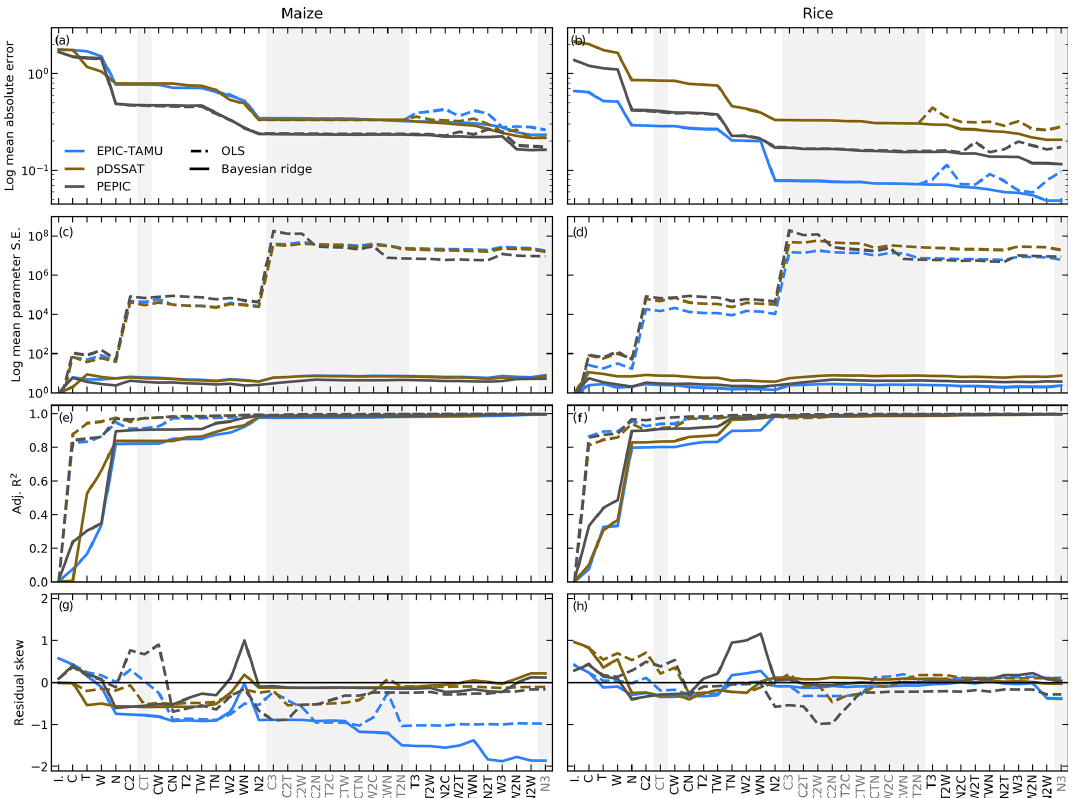
Figure 3. Illustration of results from the polynomial feature selection process for three different crop models (colors), for all grid cells with more than 1000ha cultivated for maize (left) and rice (right). Solid lines are Bayesian ridge regression results, and dashed lines are for standard OLS. Rows show four metrics of fit quality, and x axes show the terms successively tested in the statistical model, sequentially added to the model in order from left to right. Terms that do not reduce the aggregate error are marked in gray and are not included in the final model. (a, b) Log mean absolute error between emulated yield and simulated values calculated with a 3-fold cross-validation process, where the emulator is trained on two-thirds of the data and predicts the remaining third. (c, d) Log mean standard parameter error. The Bayesian ridge method strongly reduces parameter error and results in more stable estimates. (e, f) Adjusted R 2 score for the fit at each model specification. (g, h) Distribution of the residuals. Skewness is low at the high model specifications tested in all model cases other than EPIC-TAMU